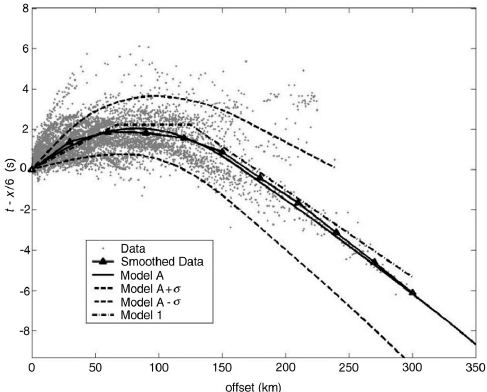
Fig. 12. Experimental data set (points) and the re- sponses calculated both for the model A (solid line) and for the model 1 (dash-dot line). The responses cal- culated for model A ±σ are shown by the dashed lines. The solid line with triangles is the optimal smoothed travel-time curve representing the experimental data.